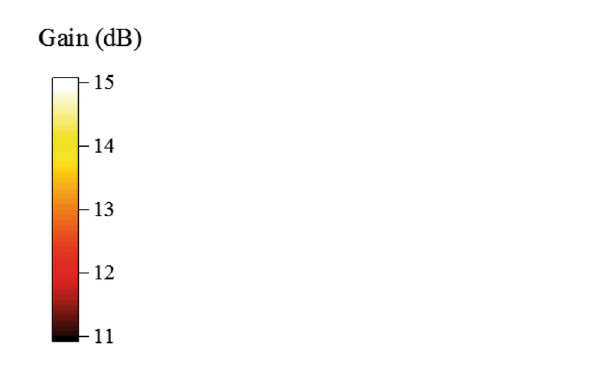
Figure 15. Measured scanning gains of the array at 5.8 GHz. Scanning gains in the near-end-fire directions (60° < ϕ < 120°, 45° < θ < 80°) are within 11~15